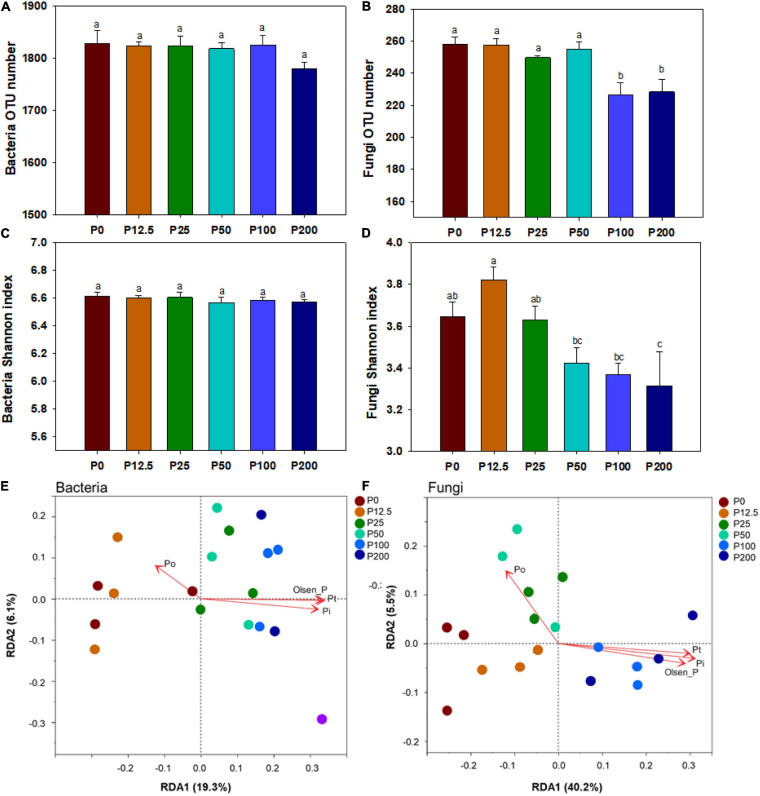
The bacterial OTU number (A), fungal OTU number (B), bacterial Shannon index (C), fungal Shannon index (D); Different lower case letters denote significantly different means on P < 0.05. Redundancy analysis (RDA) of soil physicochemical properties of bacteria (E) and fungi (F) under different P fertilization treatments. Soil physicochemical properties are fitted as vectors onto each ordination plot. Abbreviations: Po, organic phosphorus. Dotted circles with different color represent the distance between the microbial communities obtained from corresponding P fertilization rates. Abbreviations: P0, P12.5, P25, P50, P100, and P200 represent 0, 12.5, 25, 50, 100, and 200 kg P ha–1, respectively.